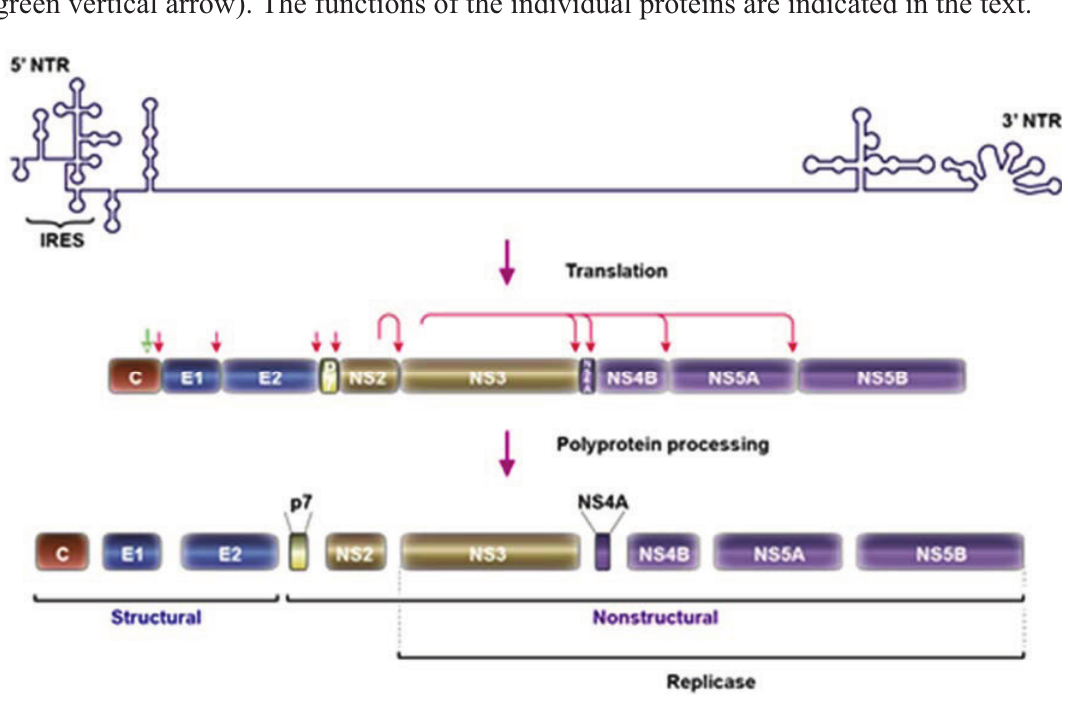
Figure 1. Genomic organization of HCV and protein synthesis. The HCV genome contains a single open reading frame flanked by 5(cid:2) and 3(cid:2) non-coding regions. The 5(cid:2) NTR contains an internal ribosome entry site (IRES). After its synthesis, the HCV polyprotein is cleaved by host signal peptidase (red vertical arrows) and by viral encoded proteases (NS2 and NS3/4A) as indicated by corresponding arrows. An additional cleavage removing the carboxy-terminal region of the core protein is mediated by cellular signal peptide peptidase (green vertical arrow). The functions of the individual proteins are indicated in the